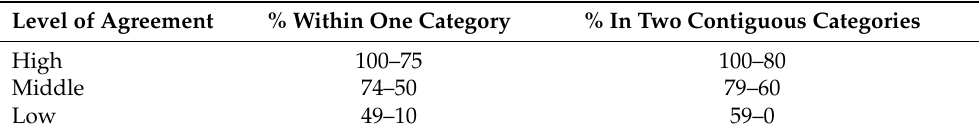
Table 1. Percentages used for measuring levels of agreement among respondents using the de Loë method [60] for measuring Delphi survey consensus. Own